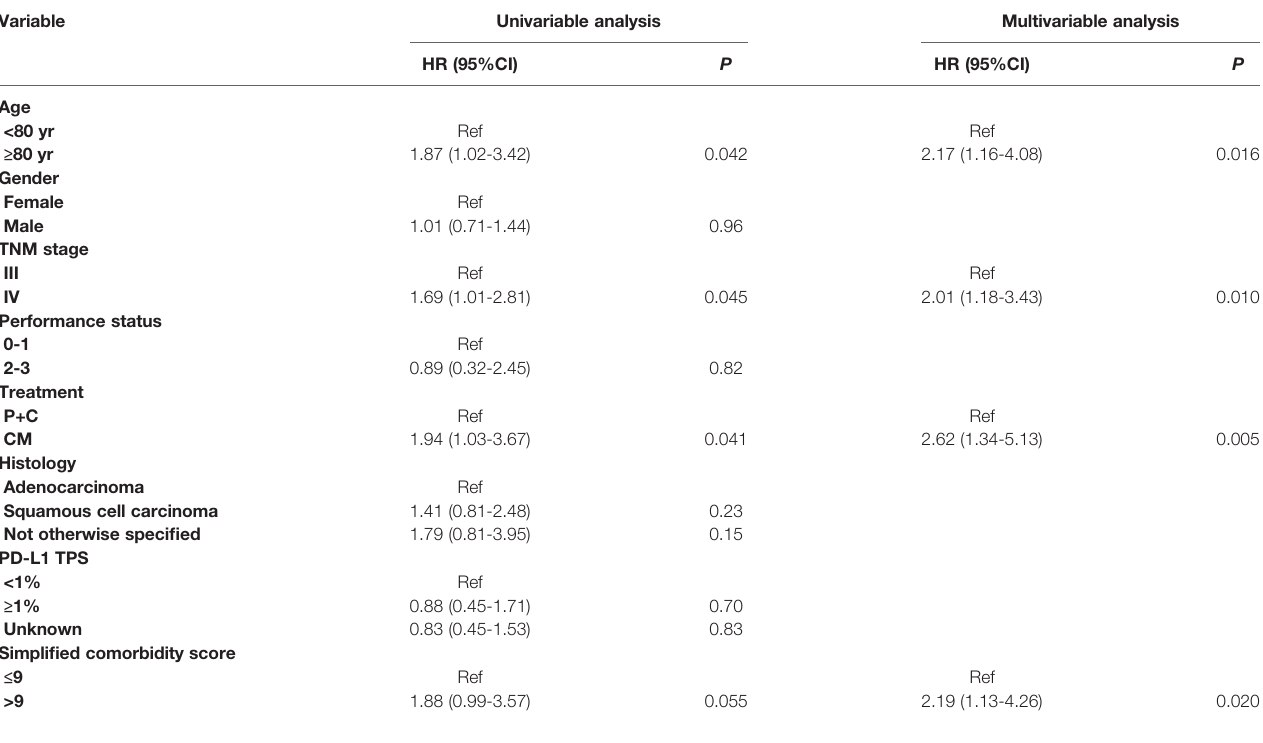
TABLE 2B | Univariable and multivariable analysis on overall